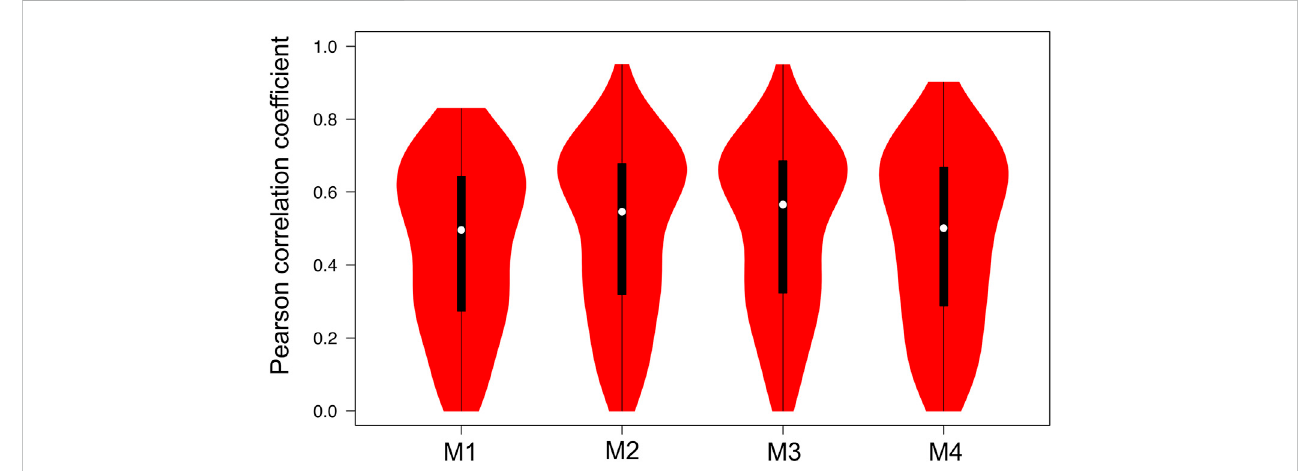
FIGURE 12 Individual R distribution obtained with each calibration method. White circles show the medians; box limits indicate the 25th and 75th percentiles as determined by R software; whiskers extend 1.5 times the interquartile range from the 25th and 75th percentiles; polygons represent density estimates of data and extend to extreme values.